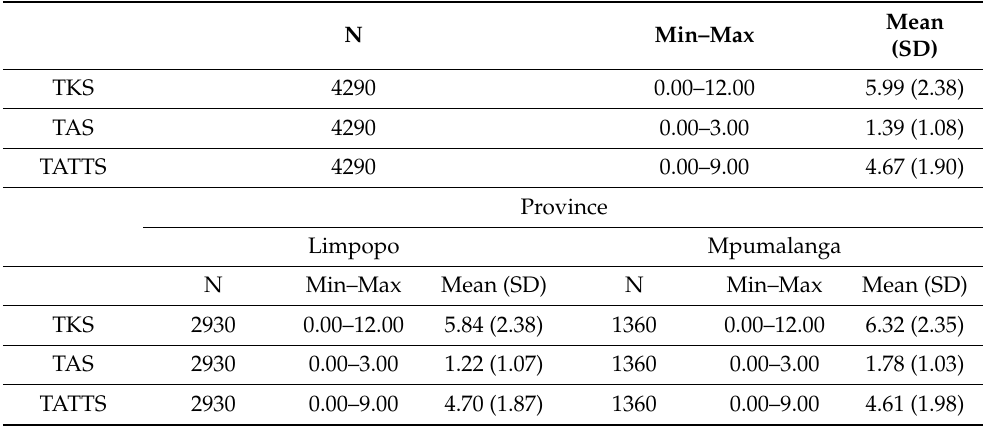
Table 2. Descriptive statistics for community members’ knowledge, awareness, and